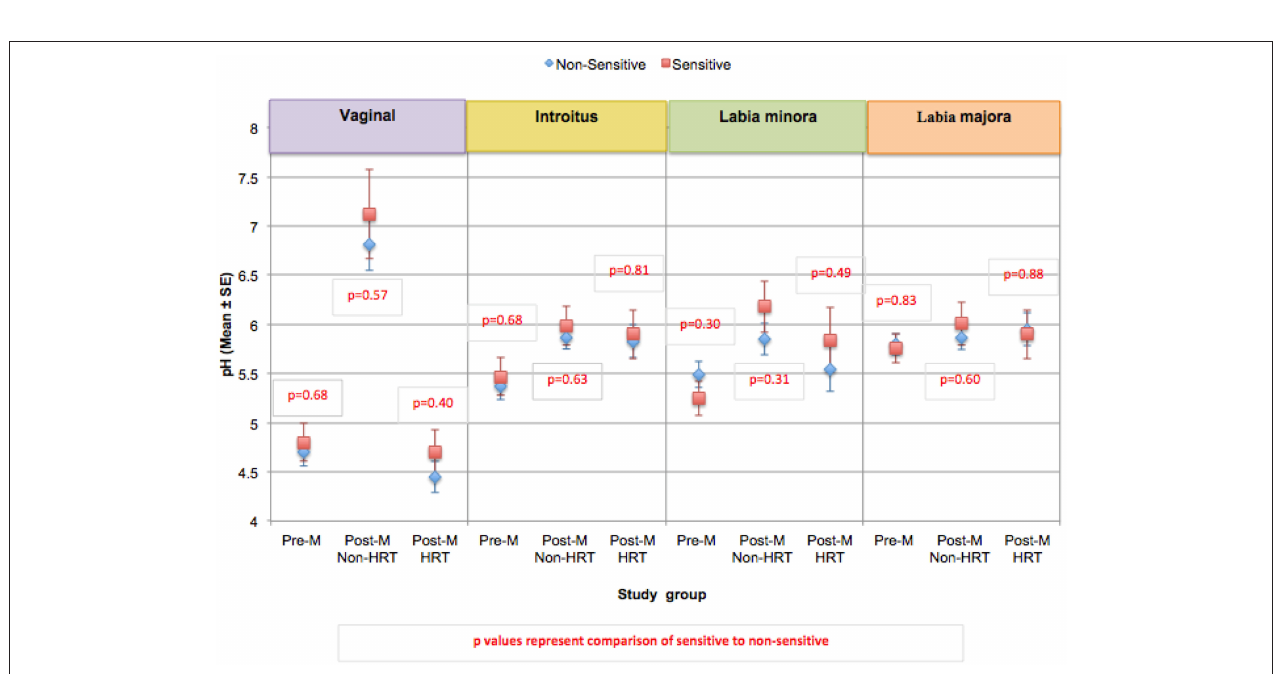
FIGURE 7 | Comparison of skin pH at genital sites among women with sensitive genital skin. In the study to evaluate biomolecular and physical measures of the urogenital skin, evaluations of skin pH were conducted at the following anatomic sites; vaginally, at the introitus, the labia minora, and the labia majora. For each group, the mean pH for those who did not have sensitive genital skin was compared to those declaring sensitive skin. The number declaring sensitive genital within each group was: Pre-M, 5; Post-M Non-HRT, 4; Post-M HRT, 5. A mixed linear model was used to analyze the pH at different anatomic sites. None of the comparisons were significantly different (i.e., p ≤